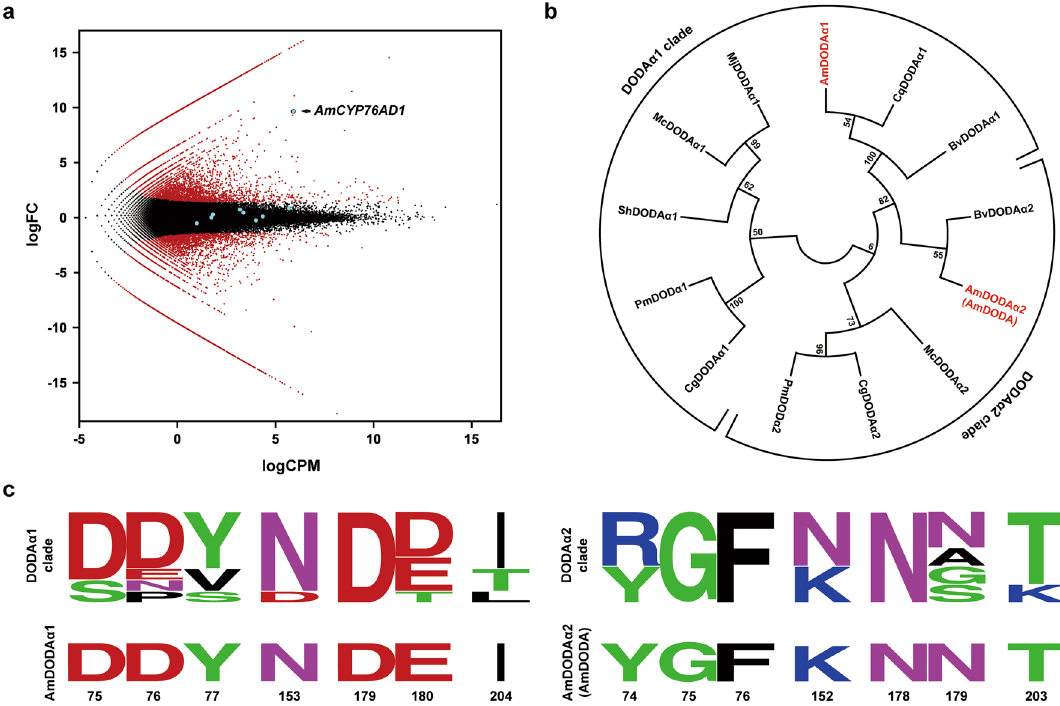
Figure 4. In silico analysis of relevant genes involved in the betalain biosynthesis pathway of A. tricolor . ( a ) The relative abundance of transcripts between AMR and AMG is presented in the MA plot (logCPM vs. logFC). Each dot presents a gene, and the relevant genes associated with betalain pigment synthesis are highlighted. ( b ) Phylogenetic tree of functionally characterized DODAα homologues. The species, families, and accession numbers of the DODAα homologues are available in Supplementary Table S6. ( c ) Proportional LOGO plots of seven functionally important residues identified by Bean et al. (2018) 21 were generated based on the DODAα1 and DODAα2 homologues listed in ( b ). Positions are numbered according to the residues of AmDODAα1 and